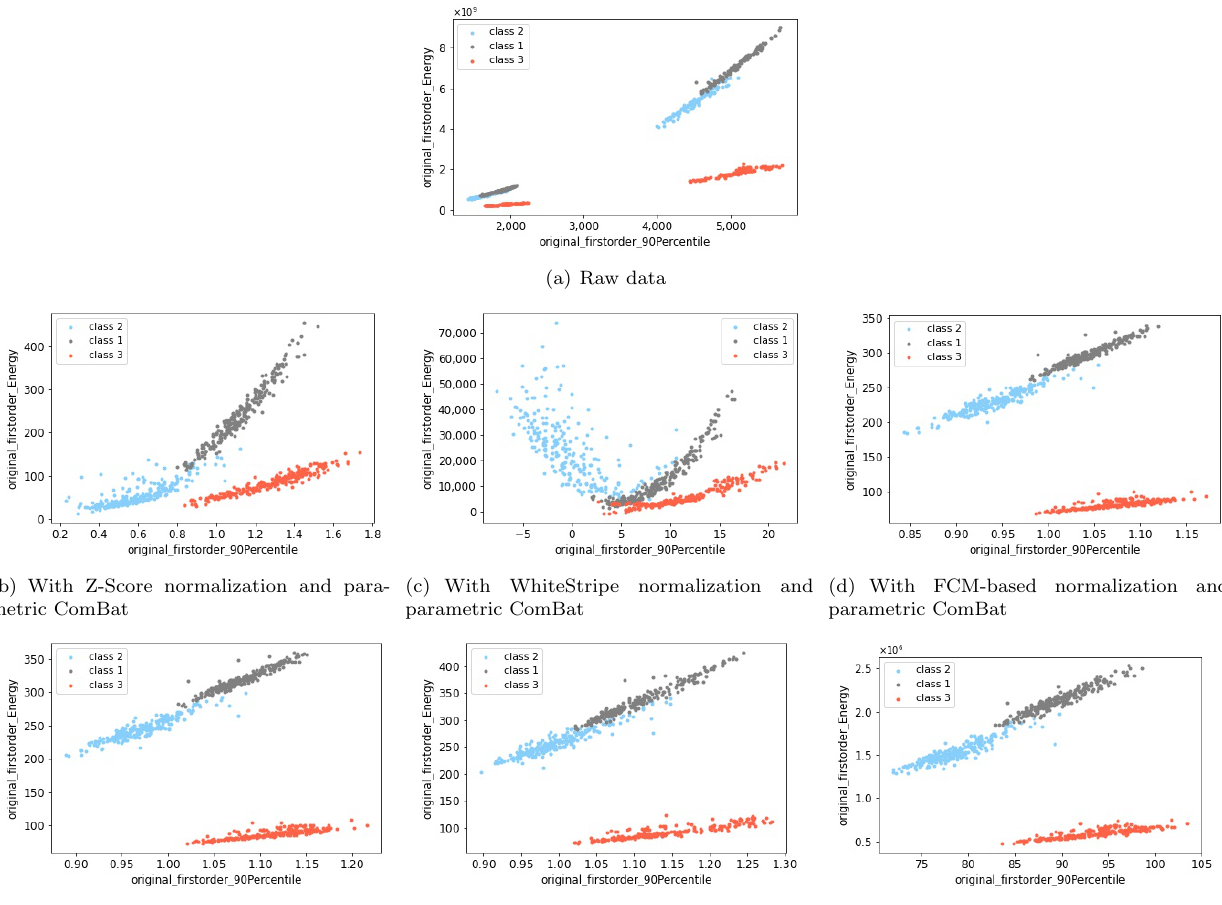
Figure 11. Visualize two example features in a 2D plane to compare different intensity normalization methods for the healthy volunteer data with different magnetic field strengths (1.5T vs. 3T). Here, “class 1”, “class 2” and “class 3” correspond to WM, GM and CC ROIs, respectively. The subfigures show the two example features acquired from MRI images ( a ) without applying any preprocessing and harmonization methods (raw data), ( b ) with applying the Z-Score normalization and parametric ComBat. ( c ) with applying the WhiteStripe normalization and parametric ComBat, ( d ) with applying the FCM- based normalization and parametric ComBat, ( e ) with applying the GMM-based normalization and parametric ComBat, ( f ) with applying the KDE-based normalization and parametric ComBat, and ( g ) with applying the Nyúl normalization and parametric